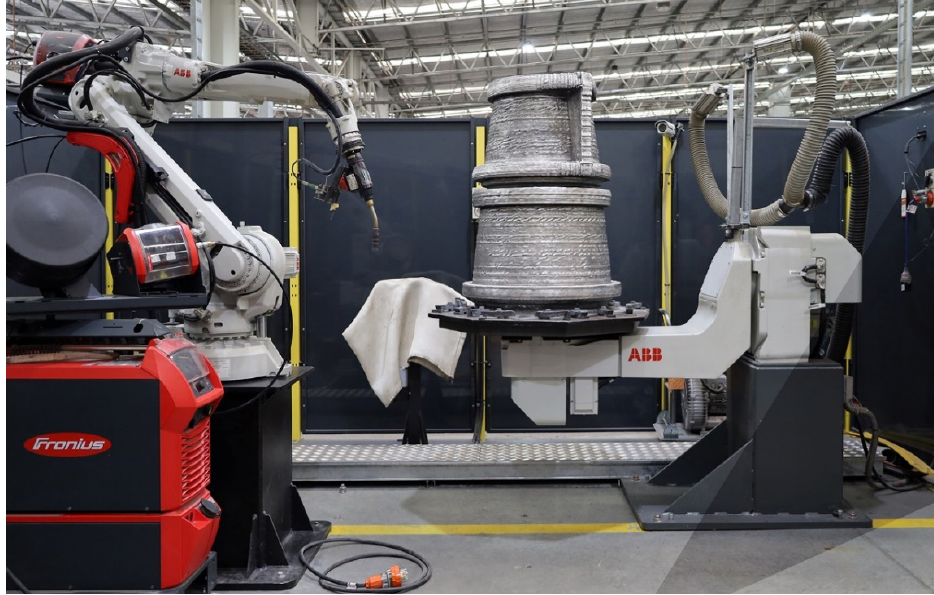
Figure 1. A typical WAAM equipment configuration using a robotic arm and a positioner table, and a WAAM bead layering in process (published with permission of AML3D Ltd., Adelaide, Australia).